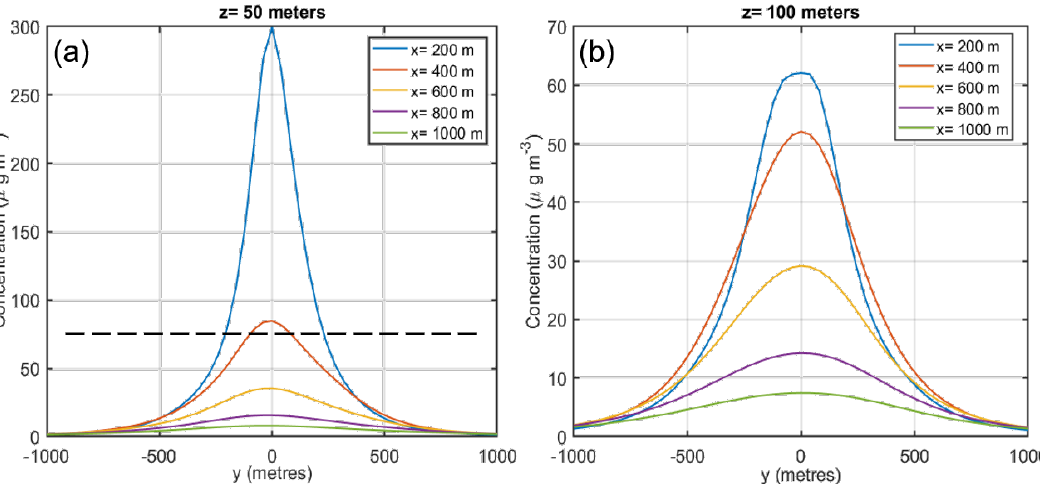
Figure 4. The profile PM concentrations are displayed along the y axis in the Gaussian dispersion model at various points (x) downstream of the emission site at altitudes (z) of ( a ) 50 m and ( b ) 100